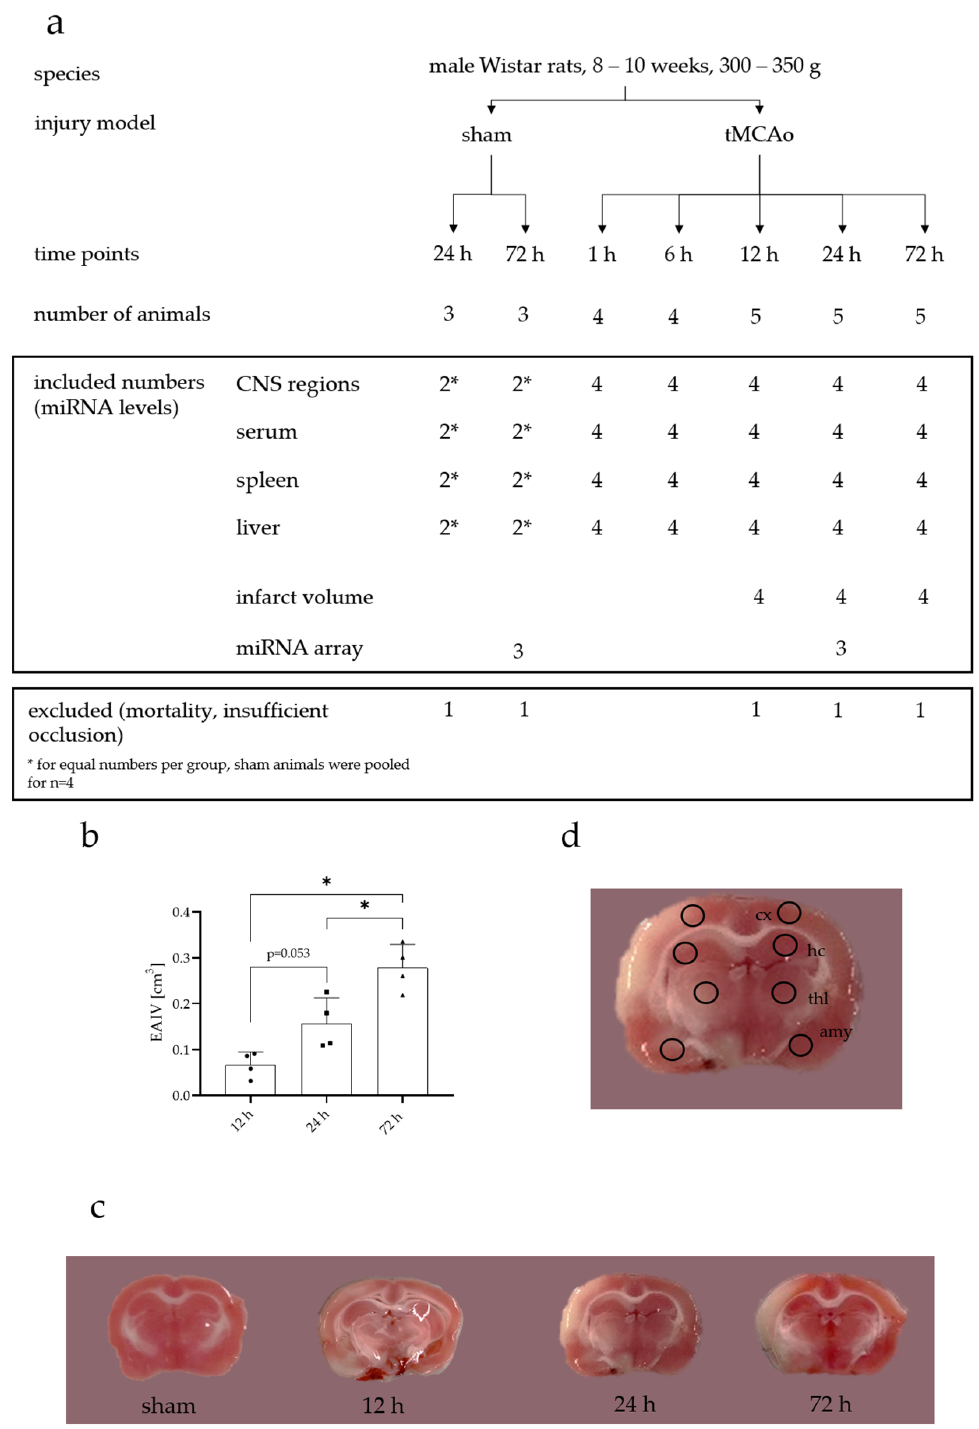
Figure A2. Animal numbers, infarct volume, and sampling location. To verify a sufficient stroke injury, we measured the infarct volume. ( a ) Animal numbers used in the study. ( b ) Edema-adjusted infarct volume (EAIV) in cm 3 for all time points. For the 1 h and 6 h time points, a TTC staining is unreliable; therefore, this was not evaluated [95]. ( c ) Exemplarily shown brain slides after TTC staining. Necrotic regions are visible in white and show the infarct region, while healthy tissue is red. ( d ) Exemplarily shown brain slides with visible sites of punched sample collection. (cx) cortex, (hc) hippocampus, (thl) thalamus, (amy) amygdala. (*) shows a significant difference between the ipsilateral side and sham